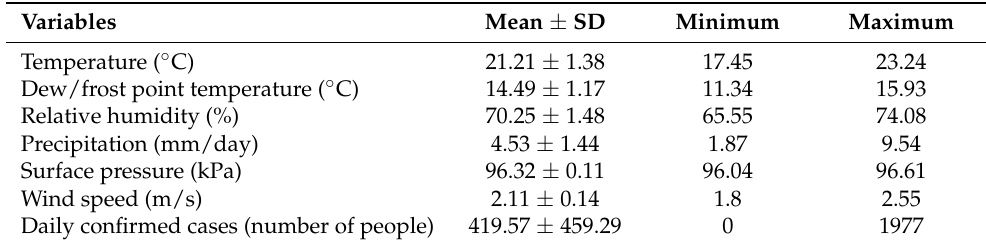
Table 1. The global descriptive statistics for the meteorological